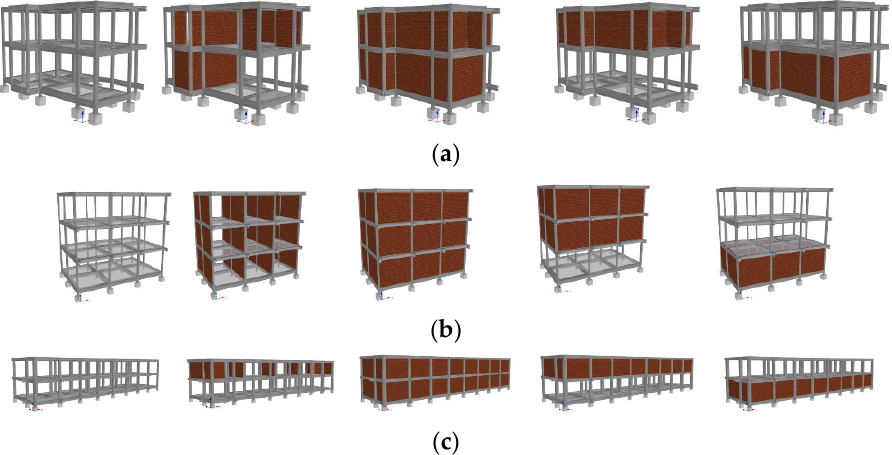
Figure 9. Various infill wall configurations of representative buildings: ( a ) RES building; ( b ) COM building; ( c ) EDU building.